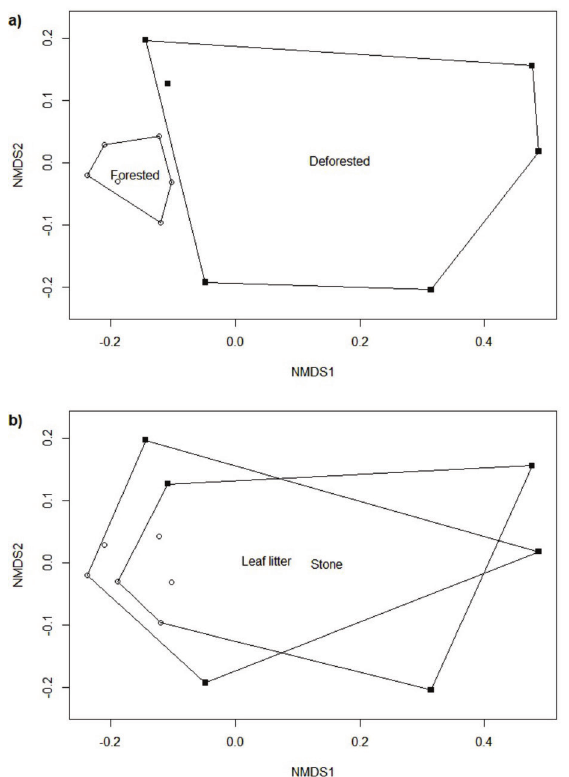
Figure 2 - Non-metric multidimensional scaling (NMDS) ordination diagram of samples from a ) forested (white squares) and deforested (filled squares) areas; b ) substrate